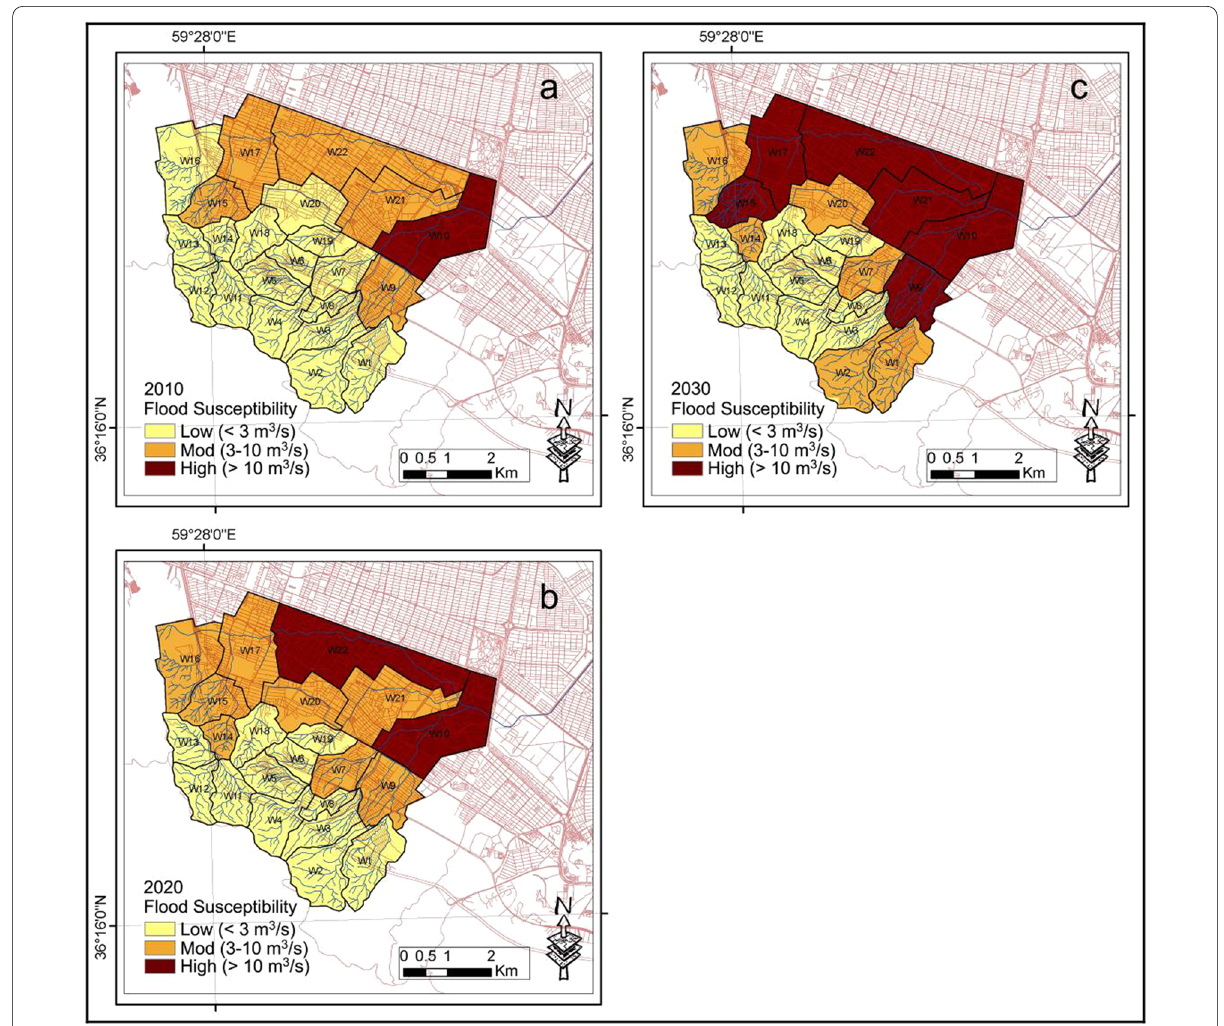
Fig. 10 Flood susceptibility evaluation of each watershed in the study area for three time windows of a 2010, b 2020, and c